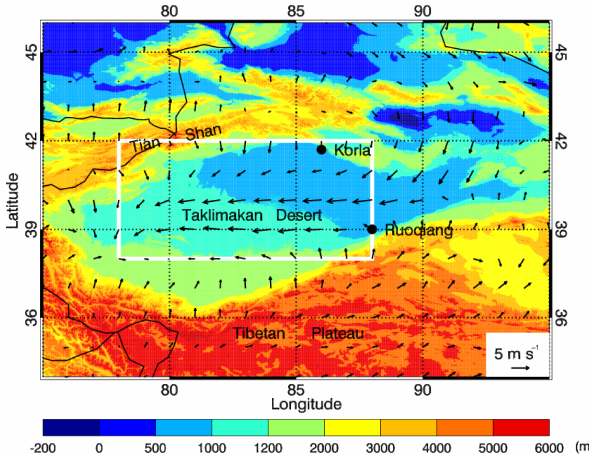
Figure 1. Map of the Taklimakan Desert region with its topography and annual mean wind at